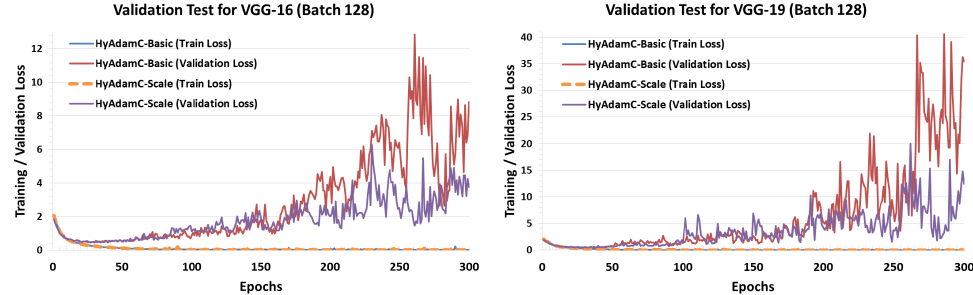
Figure 26. The training and validation loss curves of HyAdamC-Basic and HyAdamC-Scale in VGG. The left and right plots shows the loss curves of HyAdamC evaluated in VGG-16 and 19,